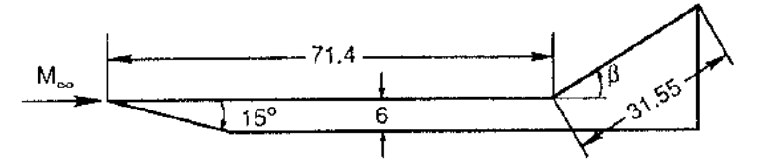
Figure 4. Two-dimensional ramp model ( β = 35°).